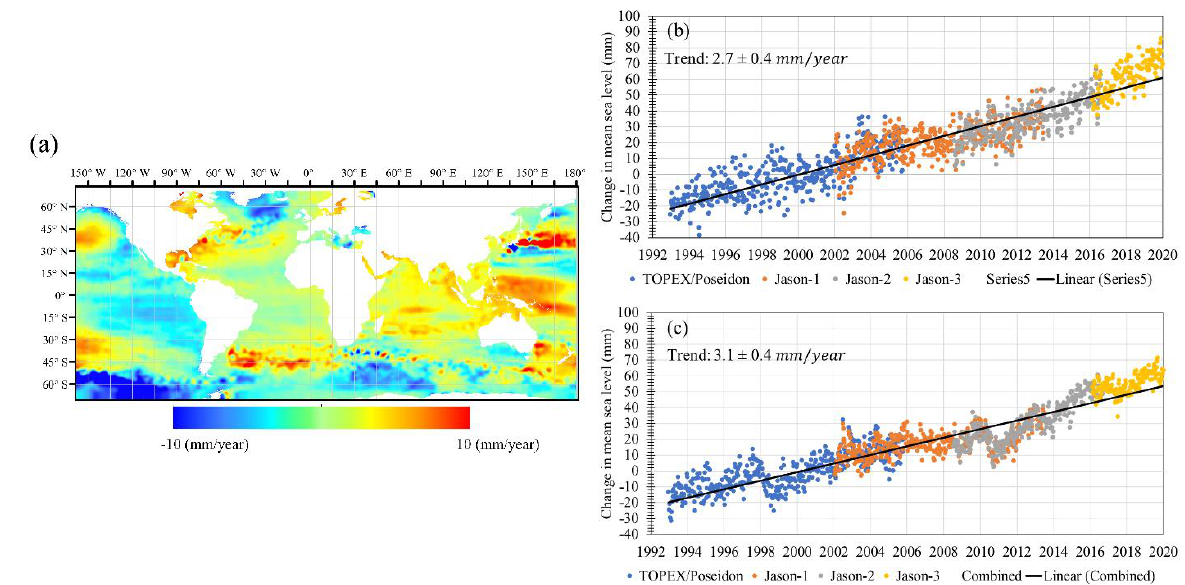
Figure 7. ( a ) Global SL change between 1993 and 2022. Regional mean SL changes and trends of ( b ) the Atlantic Ocean and ( c ) the Pacific Ocean calculated from a combination of TOPEX/Poseidon, Jason-1, Jason-2, and Jason-3 satellite altimetry datasets. Satellite altimetry data were downloaded from [211].